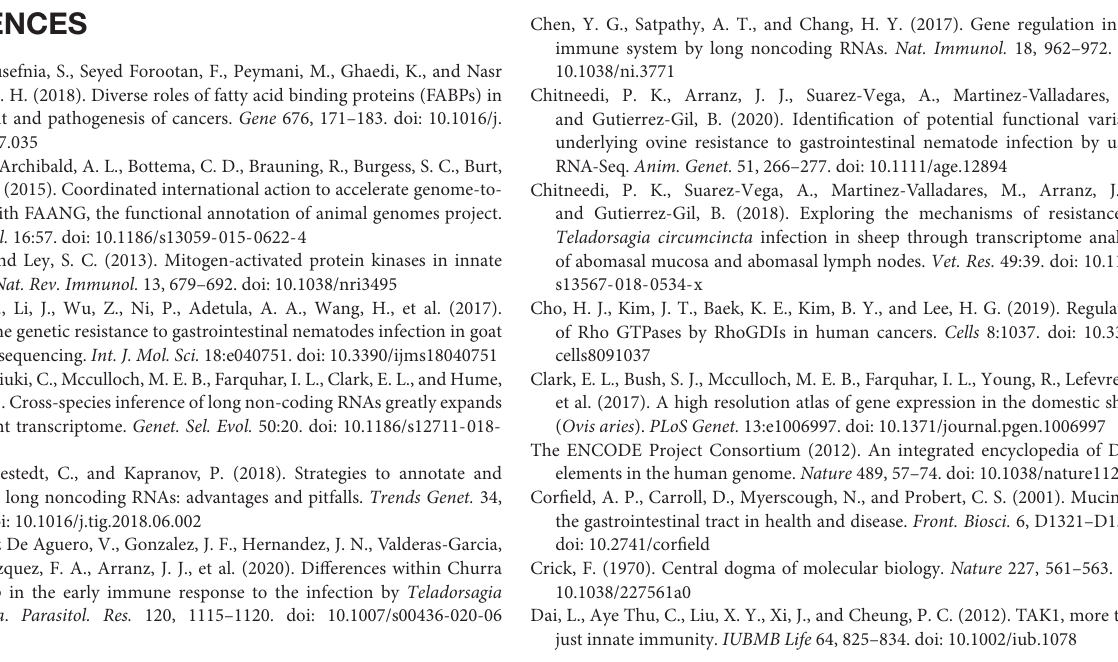
T. circumcincta. Blue bars represent the FEC values in each resistant sample and yellow bars represent the FEC values in each susceptible sample. (B) PCA performed with the read count matrix of ALN RNA-seq datasets using R function “varianceStabilizingTransformation” by specifying the sample condition (resistant and susceptible) with the initially considered 6 resistant and 6 susceptible samples. Supplementary Figure 3 | Weighted gene co-expression network matrix plot. Each block corresponds to the co-expression result of each gene network module (GNM, left ) and a lncRNA (bottom). The left axis consists of color codes for each GNM and the right axis is the correlation coefficient ( r ) reference scale with integer values and color intensity (red to blue) adopted for each lncRNA and GNM block. Each block consists of the correlation coefficient (top) and p -value (bottom) corresponding to each GNM-lncRNA pair. Supplementary Figure 4 | “EIF2 Signaling” from IPA, was the top enriched pathway with genes from the GNM ‘turquoise’ with z -score = 1.21. This figure is adapted from Ingenuity Pathway Analysis R (cid:13) . Supplementary Figure 5 | “ERK5 Signaling” from IPA, was the top enriched pathway with genes from the GNM ‘green’ with z -score = − 2.5. This figure is adapted from Ingenuity Pathway Analysis R (cid:13) . Supplementary Figure 6 | “Regulation of eIF4 and p70S6K Signaling” from IPA, was the second top enriched pathway with genes from the GNM ‘turquoise’ with z -score = − 1.34. This figure is adapted from Ingenuity Pathway Analysis R (cid:13) . Supplementary Figure 7 | “Oxidative Phosphorylation” from IPA, was one of the top enriched pathways with genes from the GNM ‘turquoise’ with z -score = 4.00. This figure is adapted from Ingenuity Pathway Analysis R (cid:13) . Supplementary Table 1 | Differentially expressed gene loci sorted based on p-value and the list of associated long non-coding RNAs (lncRNAs) along with the information of novel lncRNAs. Supplementary Table 2 | List of top 20 pathways based on − log ( p -value) enriched by the genes from the three GNMs green, yellow and turquoise according to the Ingenuity Pathway Analysis R (cid:13)